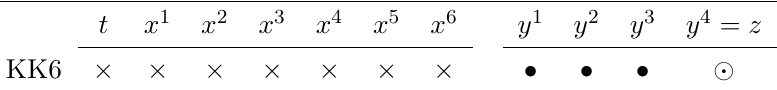
Table 3 . The identi(cid:12)cation of the internal space under a 7 + 4 Kaluza-Klein split of the KK6 background. Here, (cid:15) denotes the coordinates upon which the harmonic function depends, (cid:2) denotes worldvolume coordinates and (cid:12) denotes the Hopf cycle of the monopole solution.